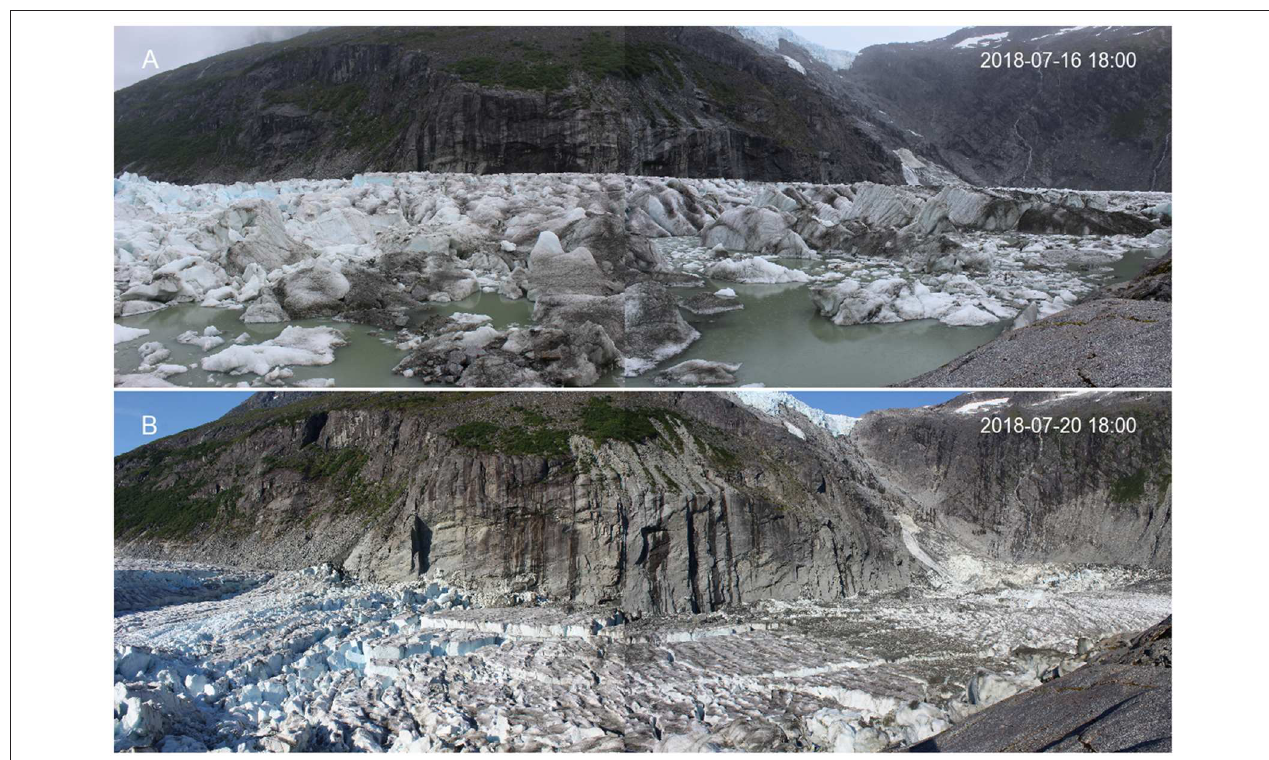
FIGURE 9 | Panorama photos of Suicide Basin at (A) peak lake level and (B) after lake drainage, based on photos from two co-located Harbortronics time-lapse cameras. In 2018, the water level dropped more than 50 m during drainage. The ice tongue inside the basin stayed mostly afloat given the partial lake